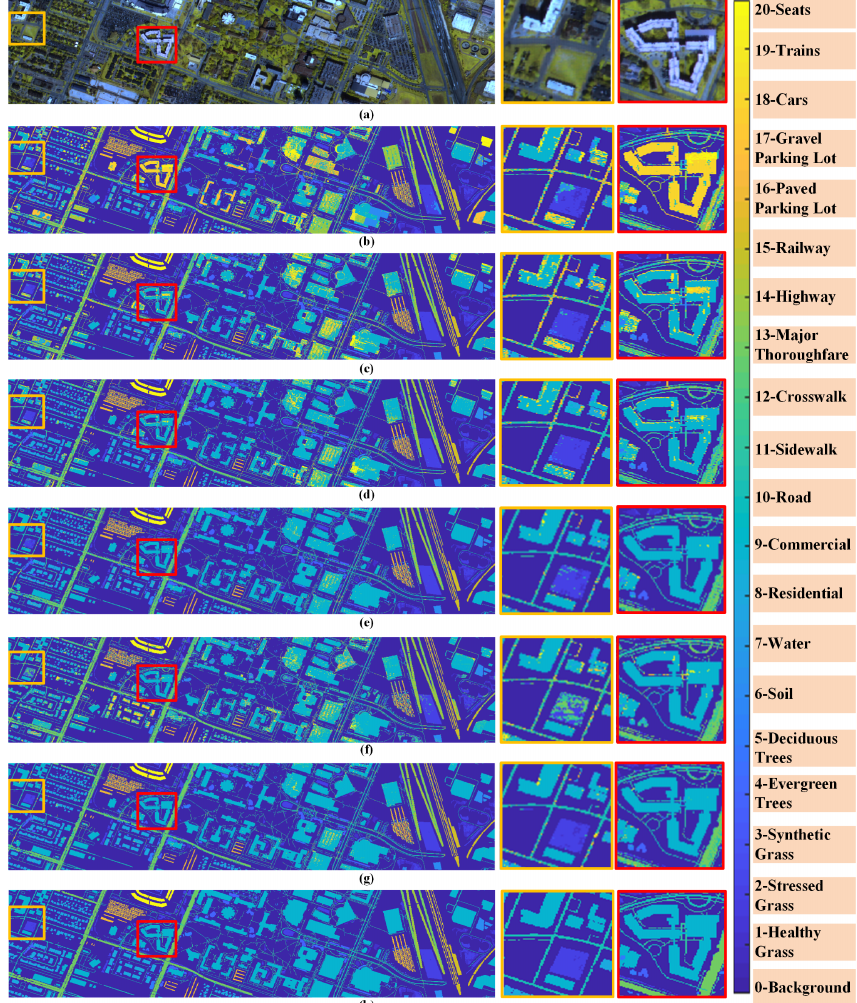
Figure 14. Classification maps of the Houston 2018 dataset with compared methods: ( a ) pseudo-color image; ( b ) FDDL; ( c ) DPL; ( d ) ResNet; ( e ) RNN; ( f ) CNN; ( g ) Ours; ( h ) ground truth. The yellow and red rectangles are corresponding to grassland andbuilding